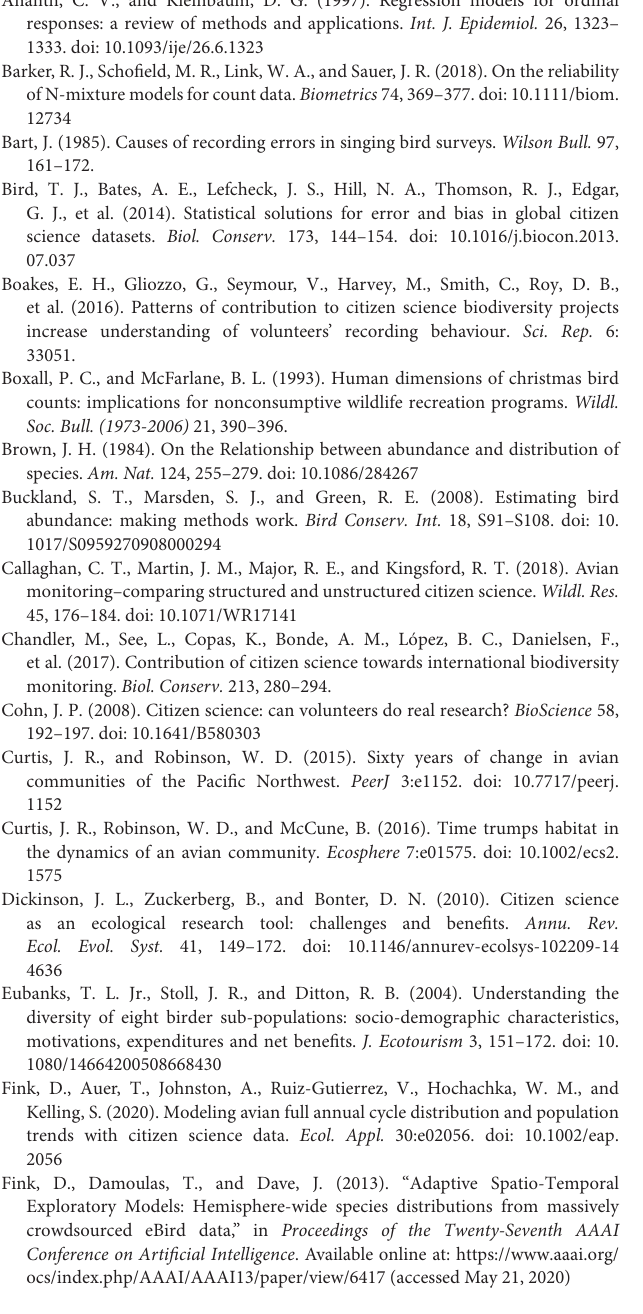
from checklists; (B) including species non-detections (zero counts) in